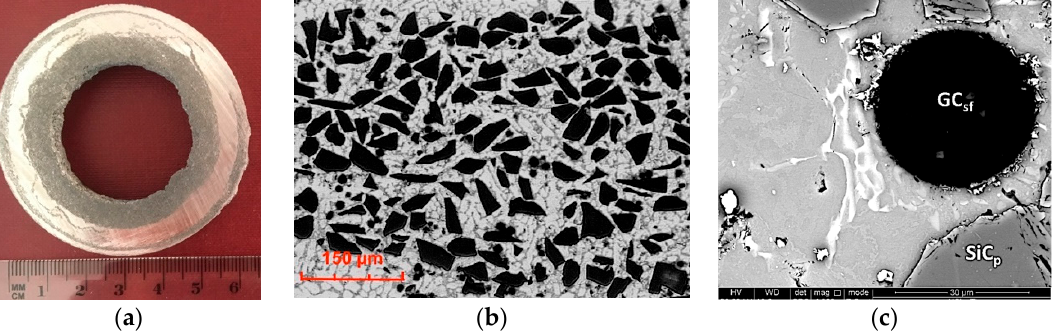
Figure 7. Cross-section perpendicular to the rotational axis of centrifugal cast obtained with AlSi7Mg1Sr0.03/SiC p 7 wt.% + GC sf 3 wt.% composite suspension: ( a ) Macrostructure with a visible internal hybrid composite layer; ( b ) Microstructure of SiC p and GC sf particles-rich regions, LM; ( c ) View of the boundary between the AlSi 7 matrix alloy and SiC p and GC sf ceramic reinforcements, SEM.